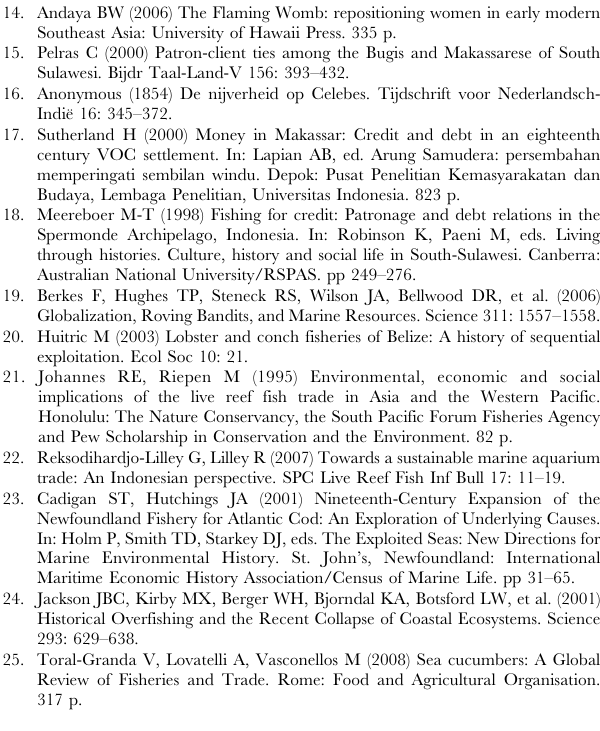
Table S2 Makassarese trepang export and production